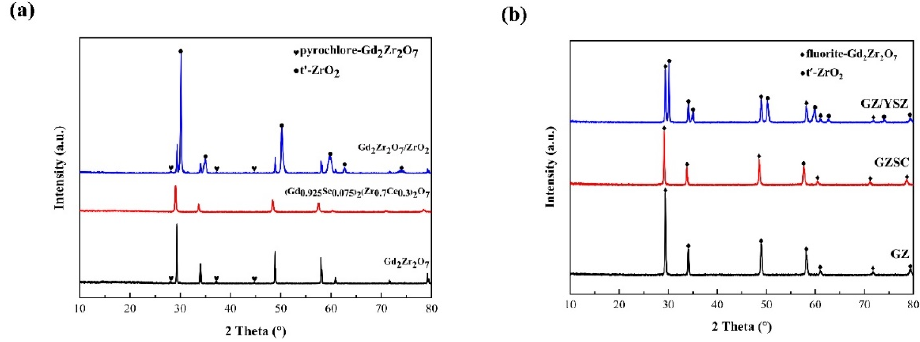
Figure 3. XRD patterns of ( a ) powders and ( b ) as-sprayed coatings.